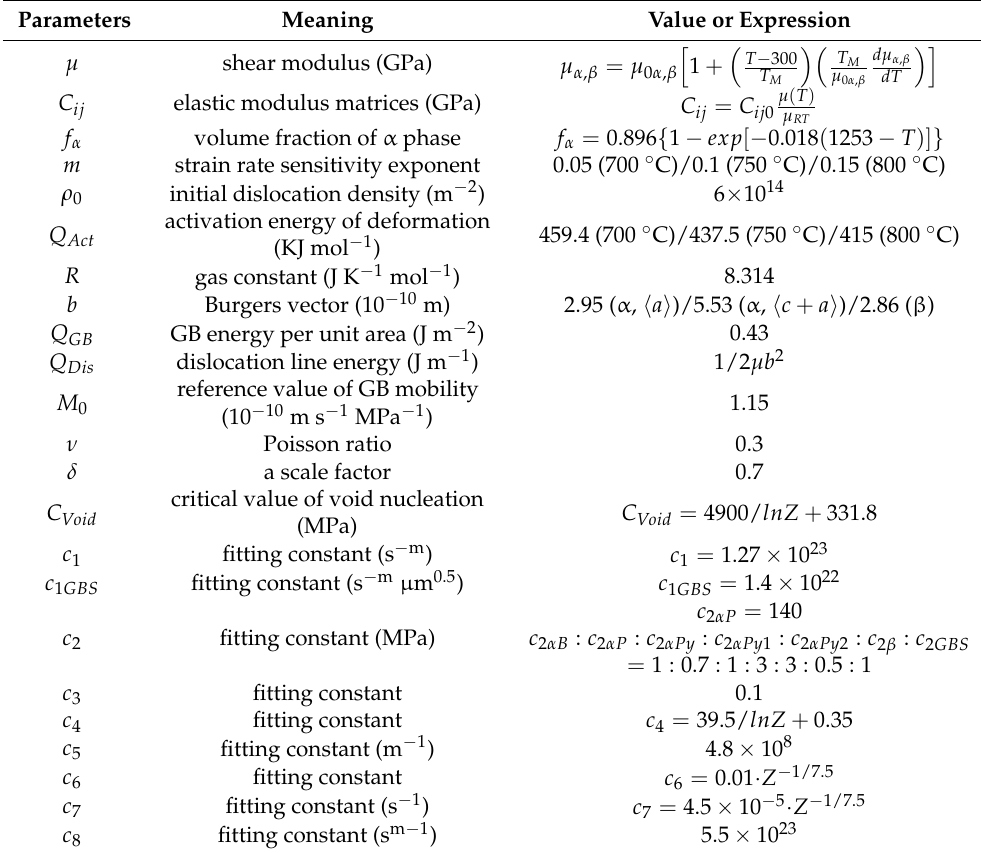
Table 1. Parameters of crystal plasticity constitutive model of TA15 titanium alloy during non- superplastic hot